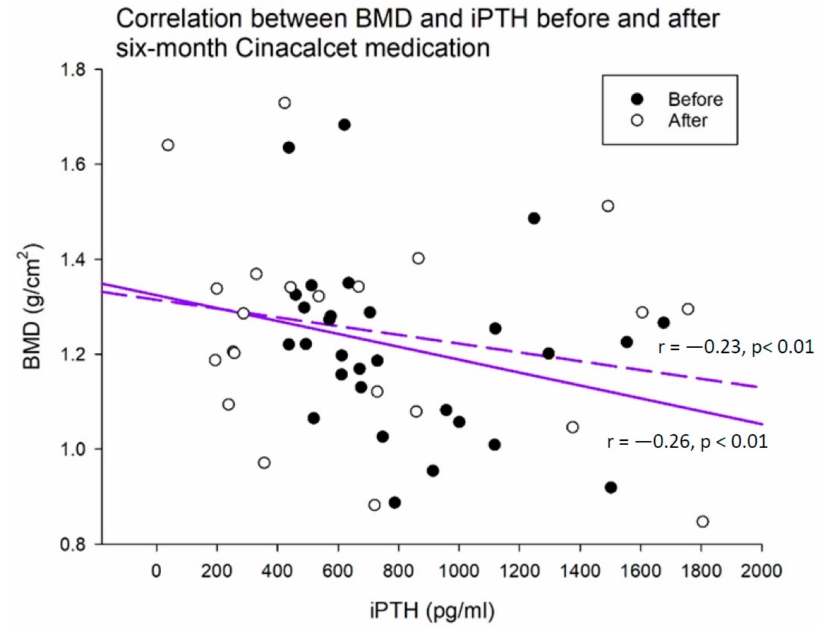
Figure 2. Correlations between BMD and iPTH before (dash line) and after (solid line) six-month treatment of Cinacalcet. A significantly inverse correlation exists between BMD and iPTH before and after treatment. Compared with the pre-treatment slope, the post-treatment slope increases inversely, suggesting that BMD improvement is correlated with suppression of iPTH. Table 3. Univariate logistic regression analysis of parameters associated with responsiveness to Cinacalcet treatment among hemodialysis (HD) patients with secondary hyperparathyroidism (SHPT).